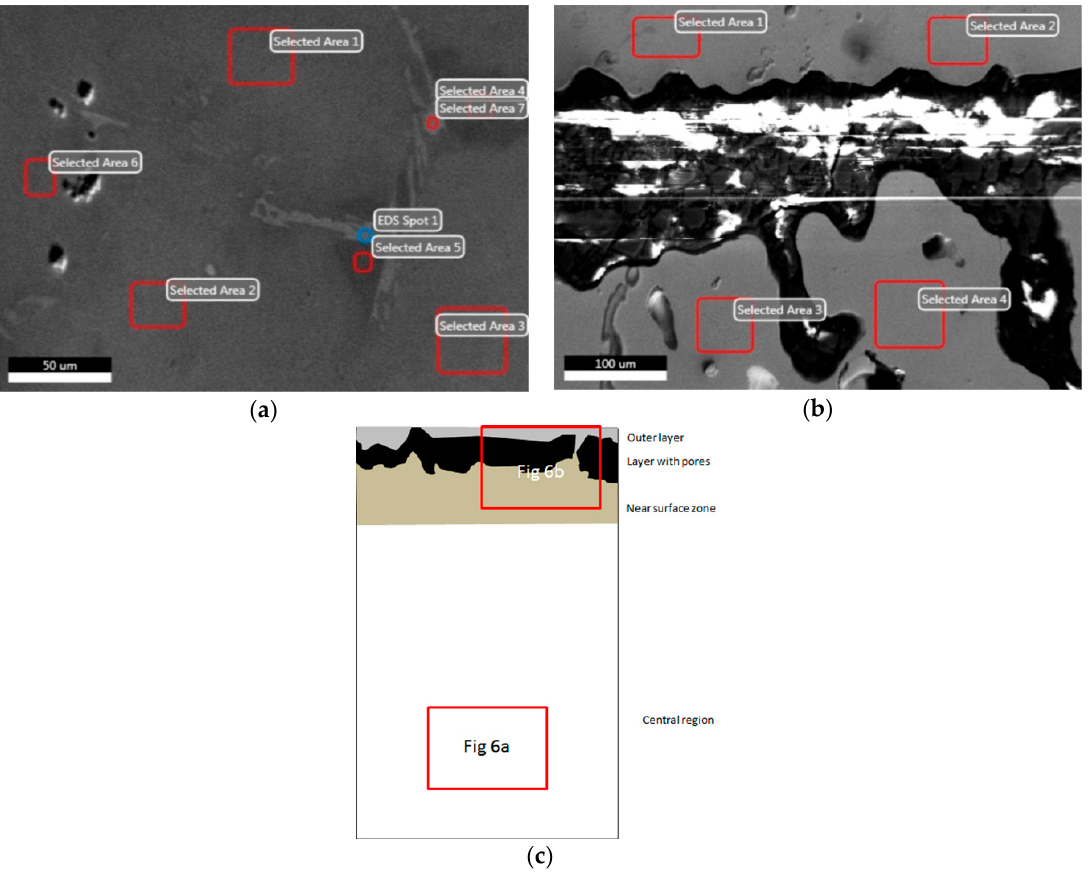
Figure 6. Micrographs used for EDS analysis. ( a ) 1000 ppm B sample after in-situ measurement, central region, ( b ) 1000 ppm B sample after in-situ measurement, surface region (the bottom part depicts the near-surface zone, the upper part corresponds to the outer layer), ( c ) scheme (not to scale) of the position of Figure 6a,b with respect to the surface.